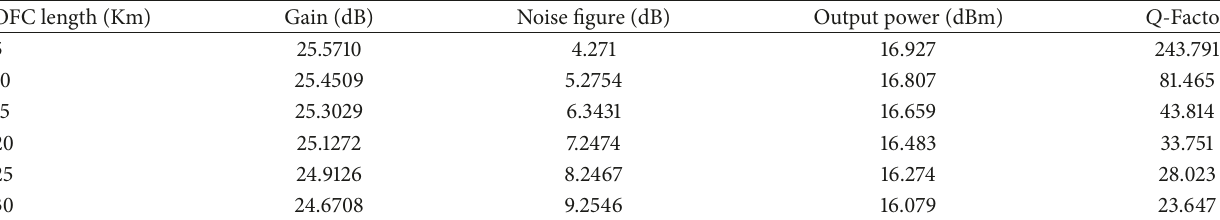
Figure 3: Fiber Bragg Gratings. Table 1: Output readings by varying the OFC length